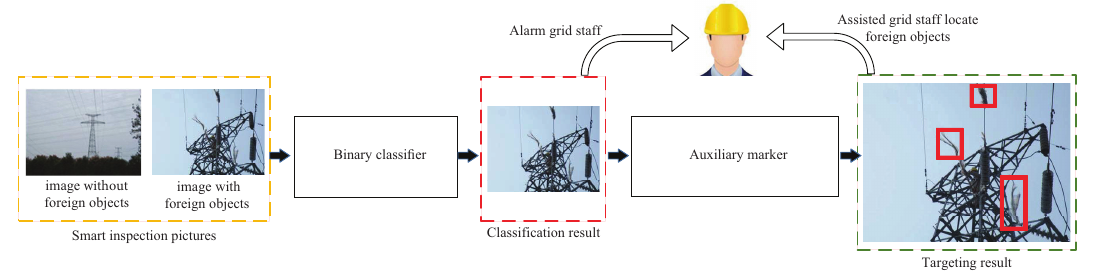
Figure 2. Warning–review strategy.